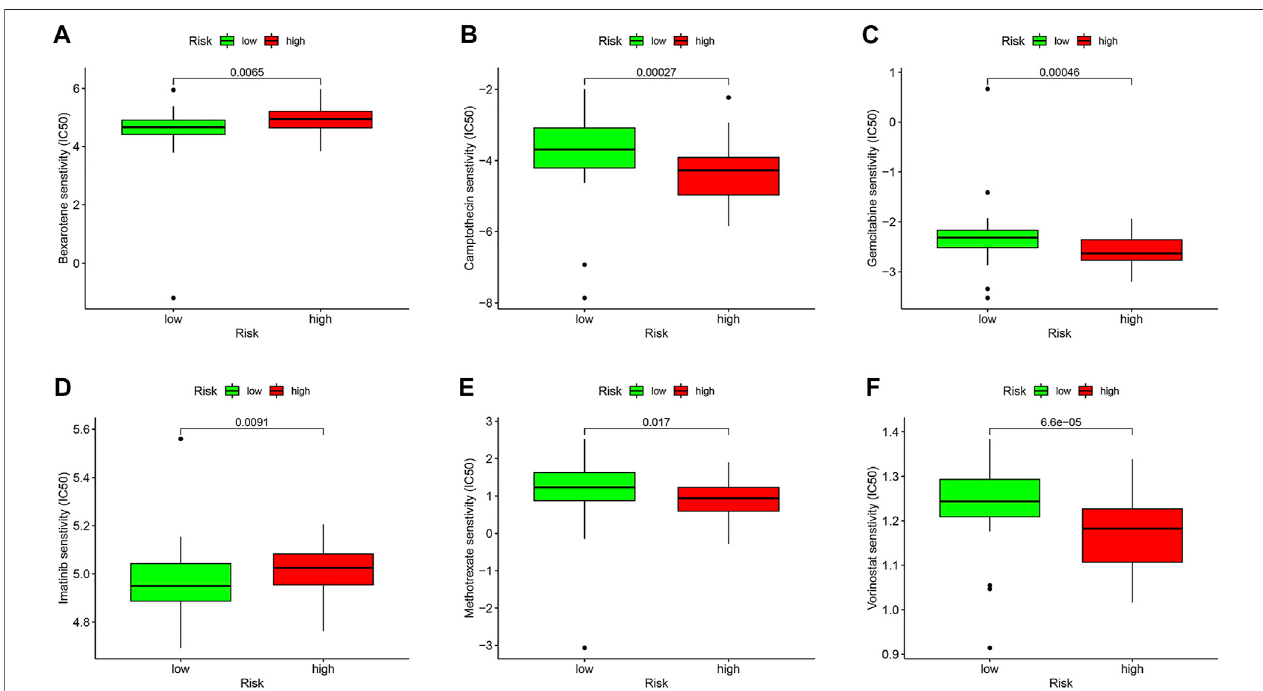
FIGURE 9 | Drug sensitivity analysis in the TCGA database. Box plots demonstrate the estimated IC50 values of bexarotene (A) , camptothecin (B) , gemcitabine (C) , imatinib (D) , methotrexate (E), and vorinostat (F) . The lower the IC50 value, the higher is the sensitivity to the drug.